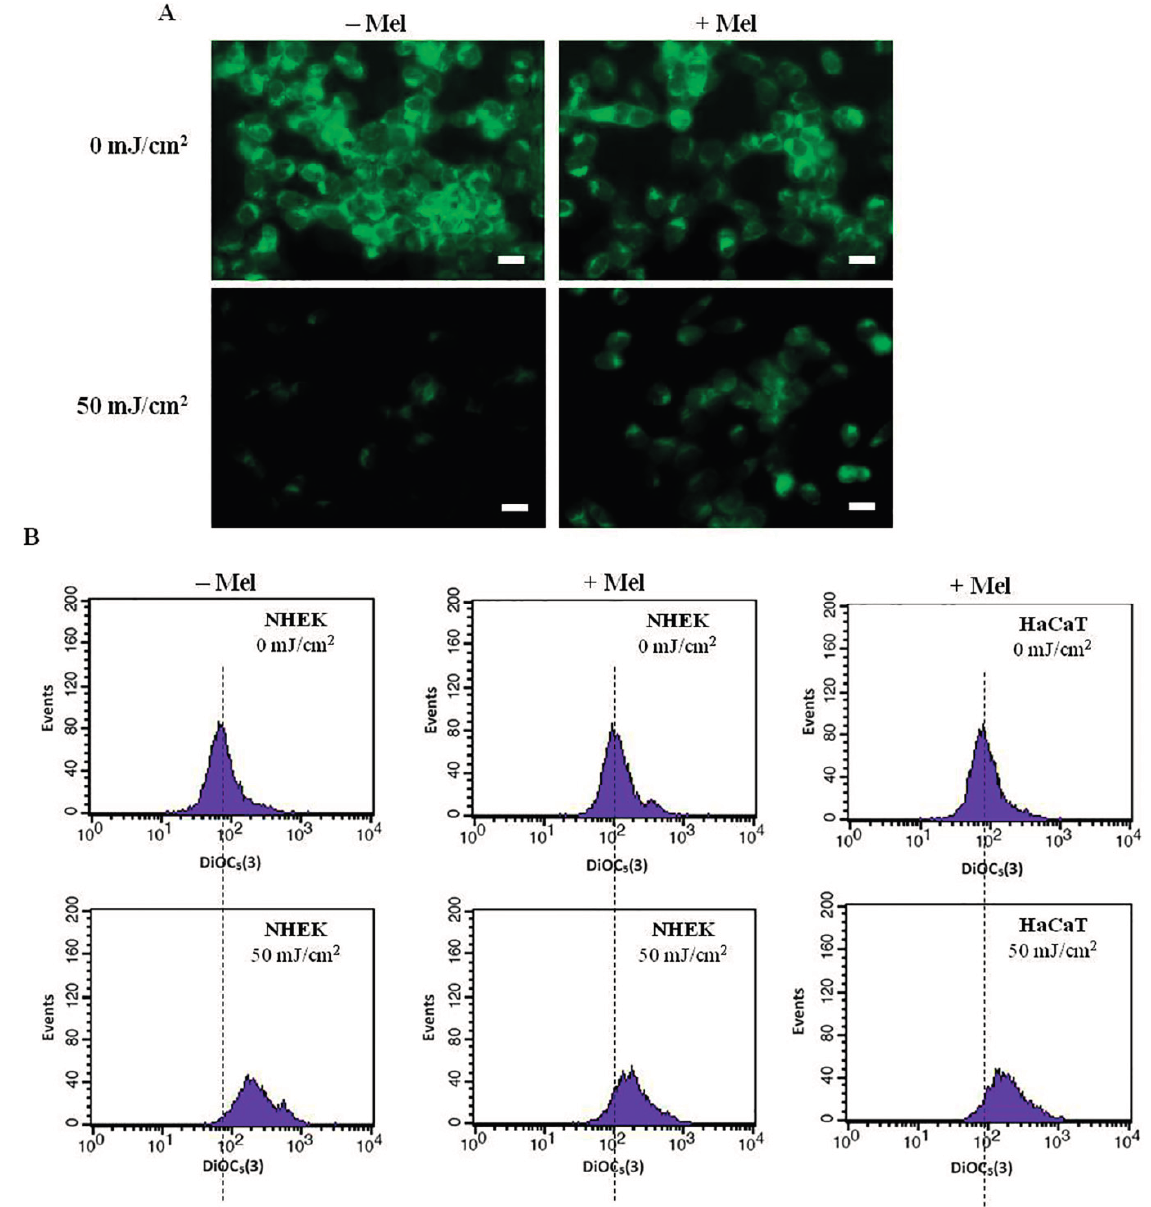
Figure 5. Protective effect of melatonin against UV-induced alterations within plasma membrane in human keratinocytes. ( A ) Fluorescent images of normal human keratinocytes (NHEK) (magnification, 40×) presenting the impact of UVR and melatonin. A representative experiment is shown. Bars = 20 μ m; ( B ) Plasma membrane potential histograms obtained by flow cytometry after 24 h post-UVR (50 mJ/cm 2 ) in HaCaT and NHEK keratinocytes. The horizontal axis indicates DiOC 5 (3) fluorescence intensity and the vertical axis indicates number of cells. The histograms shifted to the right upon UVR exposure (hyperpolarization of mb Δψ ) while presence of melatonin reversed this effect (modified after Kleszczy ń ski et al. [142] with permission from the